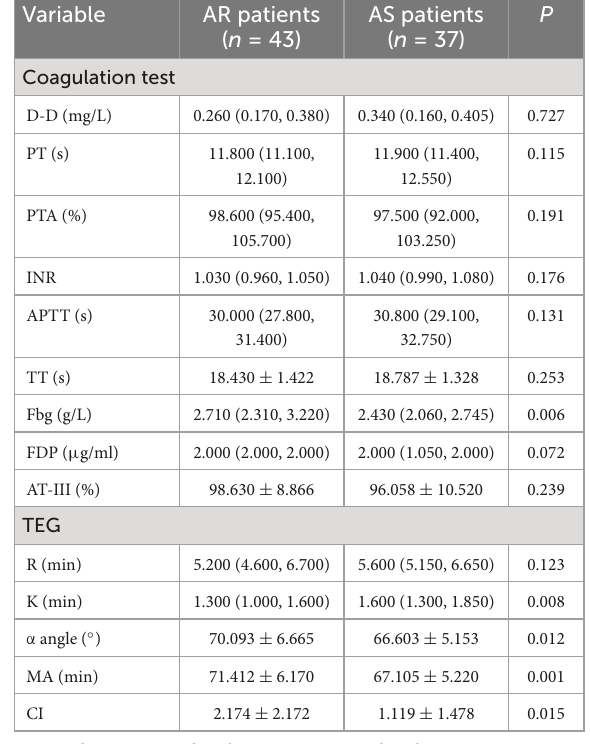
TABLE 2 Comparison of coagulation status between AR patients and AS